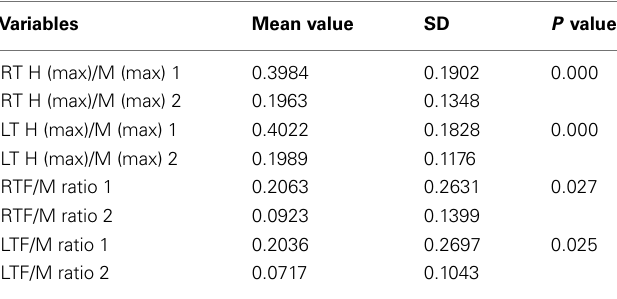
Table 3 | Comparison between mean value of LT H (max)/M (max) and RT H (max)/M (max), before and after EPPS application in veterans who conducted the pattern of optimal exercise with